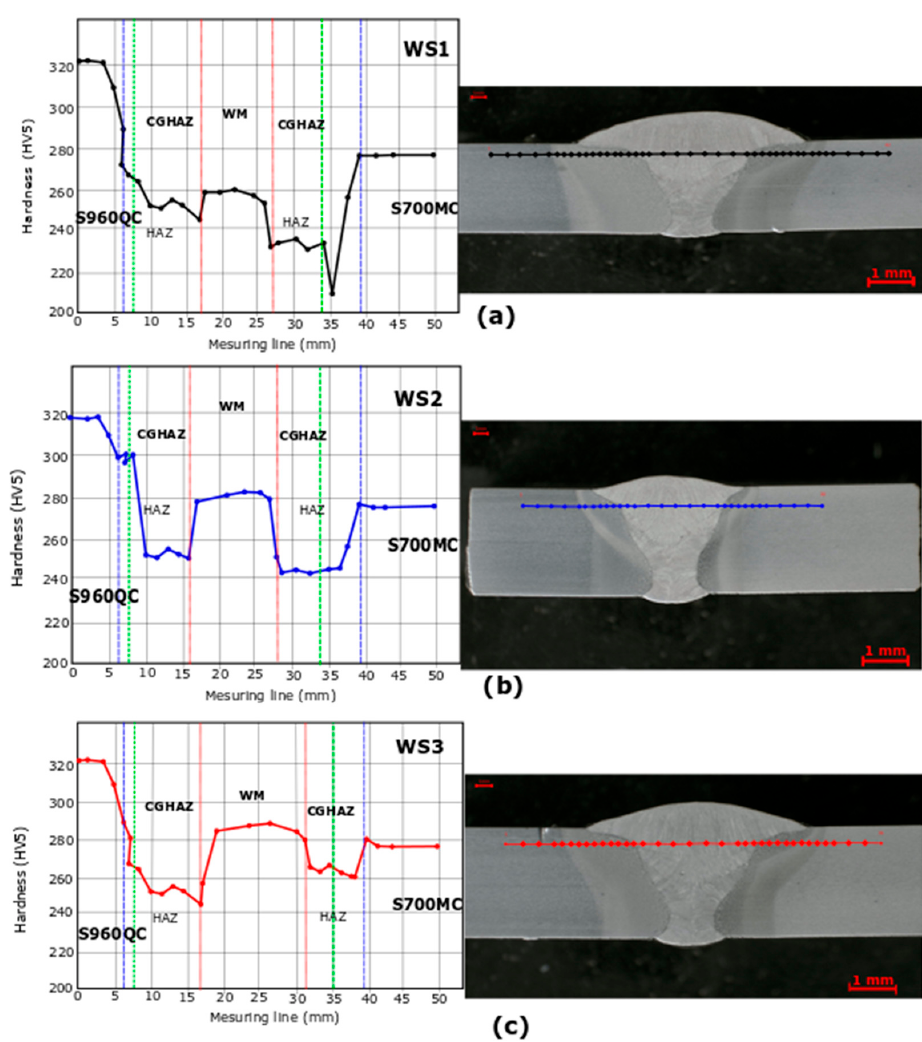
Figure 6. Hardness profile across the weld samples (WS): ( a ) hardness profile of WS1, ( b ) hardness profile of WS2, ( c ) hardness profile of WS3.